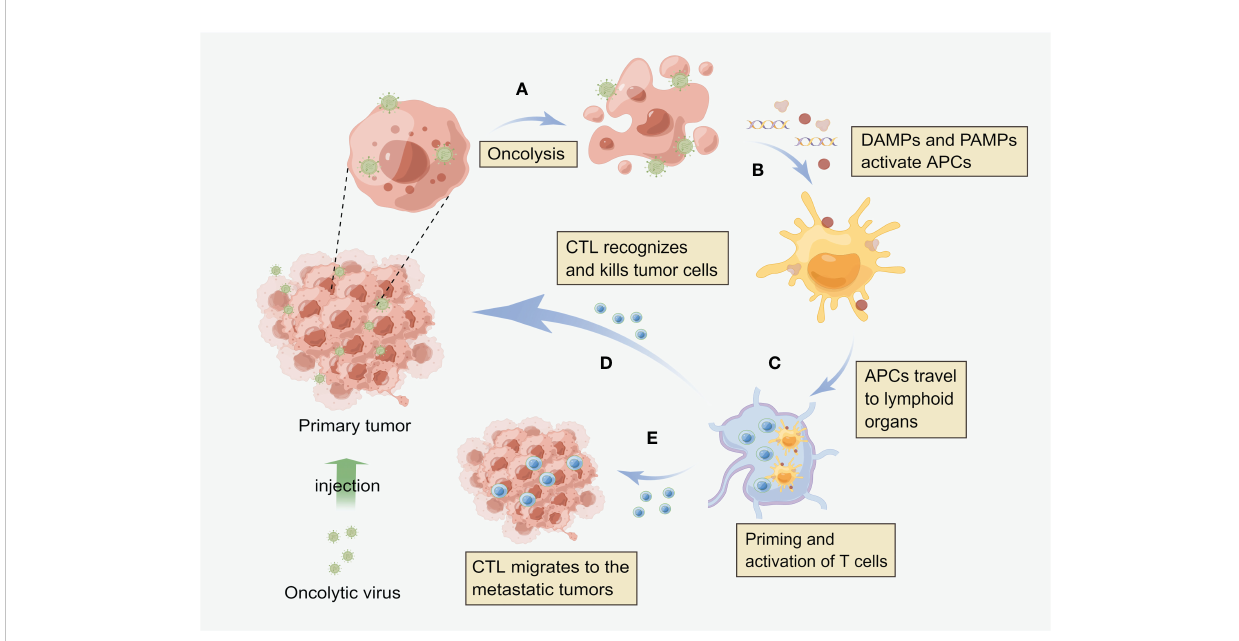
FIGURE 1 Oncolytic virus induces local and systemic anti-tumor immunity (A) After virus infects tumor cells, it replicates in a large number of cells and directly kills tumor cells. (B) After cell lysis, the release of soluble tumor associated antigen (TAA), viral pathogen associated molecular model (PAMP) and cell-derived injury associated molecular model (DAMP) enables antigen presenting cells (APCs) to be recruited to the viral infection site and activate. (C) APC engulfs antigens and migrates to lymph nodes, where adaptive T cell immunity against tumors is initiated. (D) These cytotoxic T cells (CTLs) can recognize and kill tumor cells. (E) Distant metastatic tumor is also the target of CTL, i.e. CTL can migrate to the distant tumor